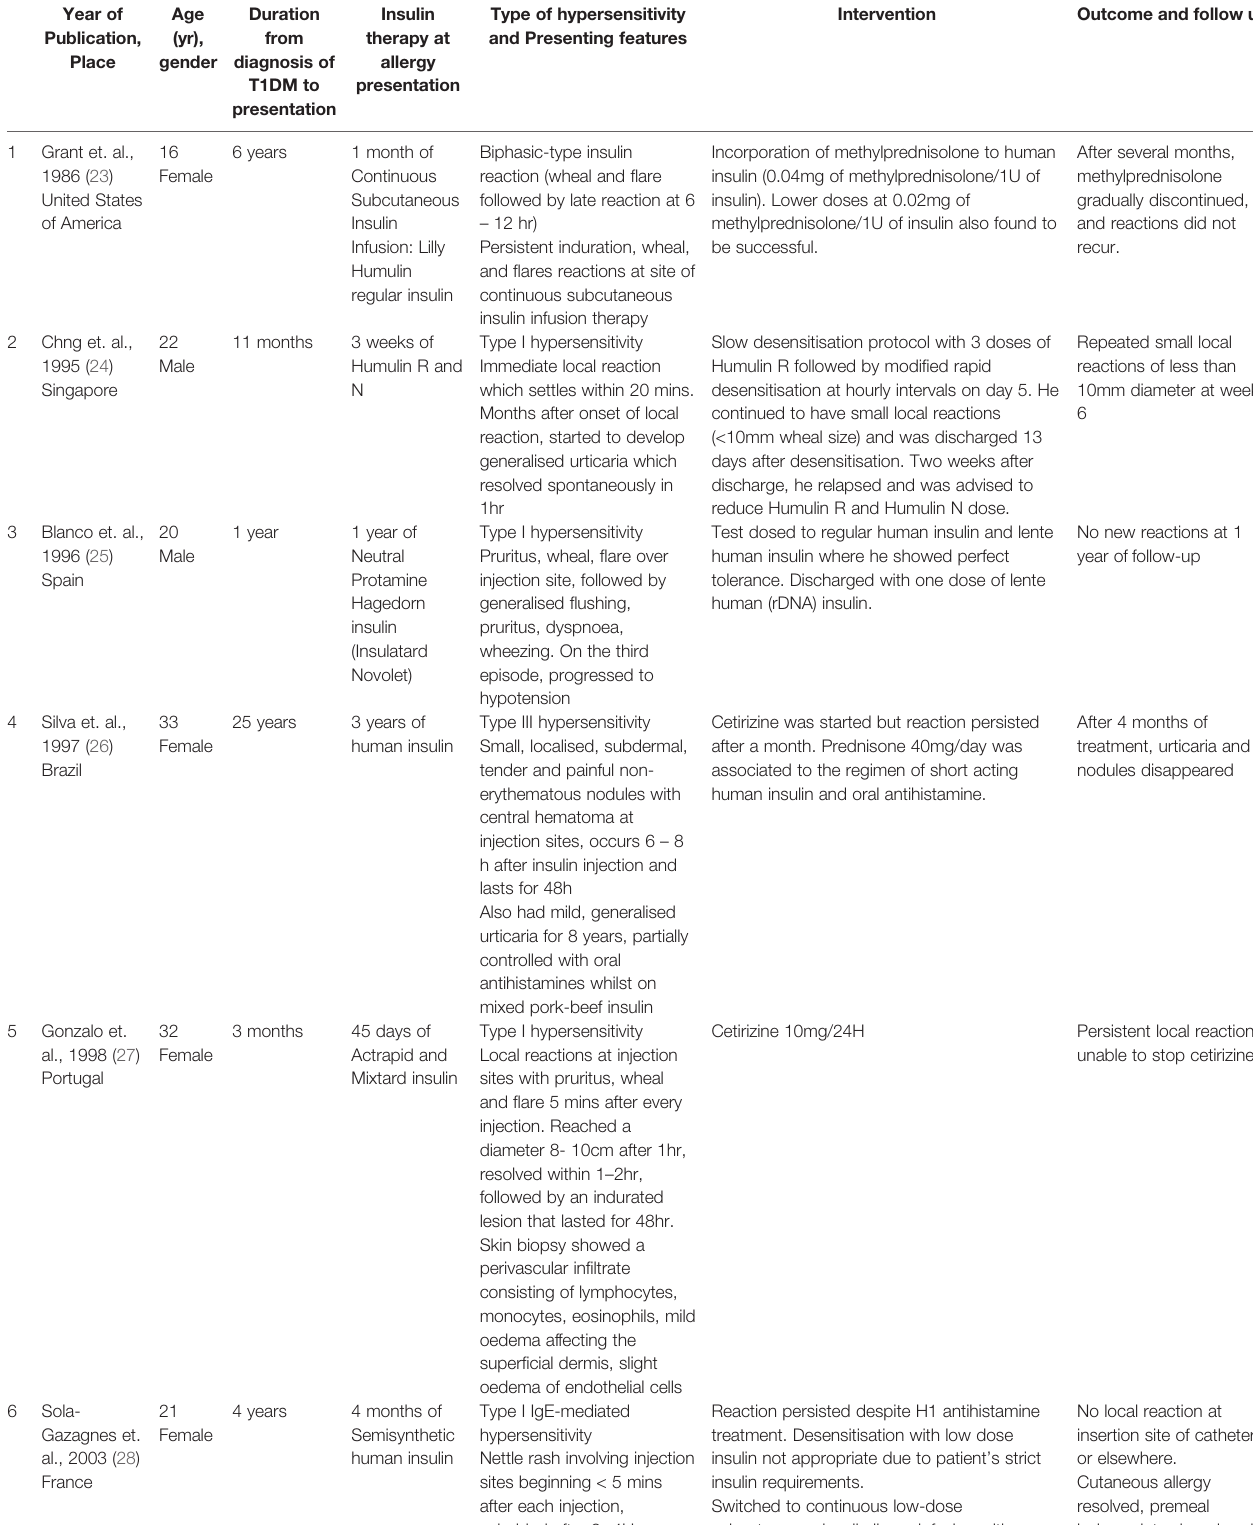
TABLE 1 | Literature review of presentation and management of patients with type 1 diabetes mellitus with insulin